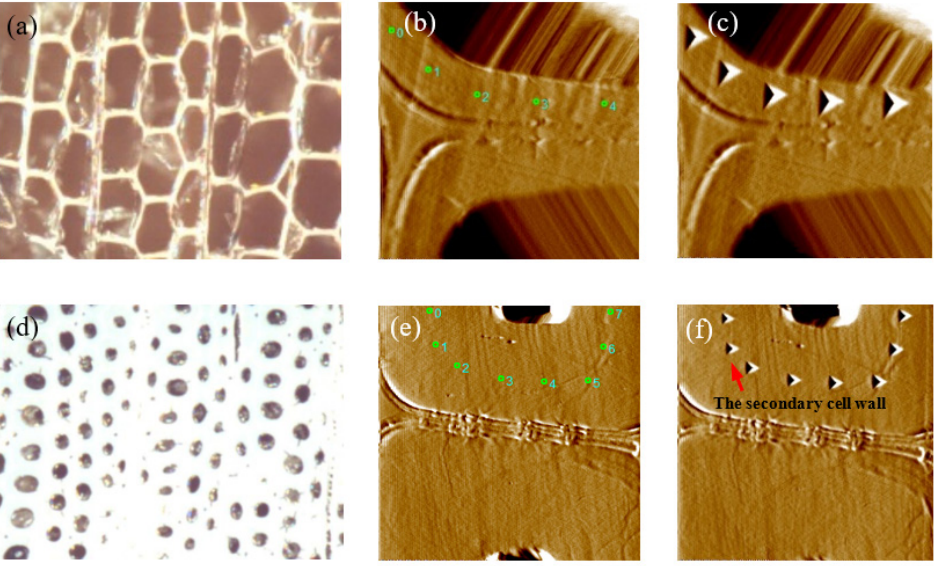
Figure 2. NI test area ( a , d ), test points and indentation after unloading ( b , c , e , f ). EW ( a – c ), LW ( d – f ).